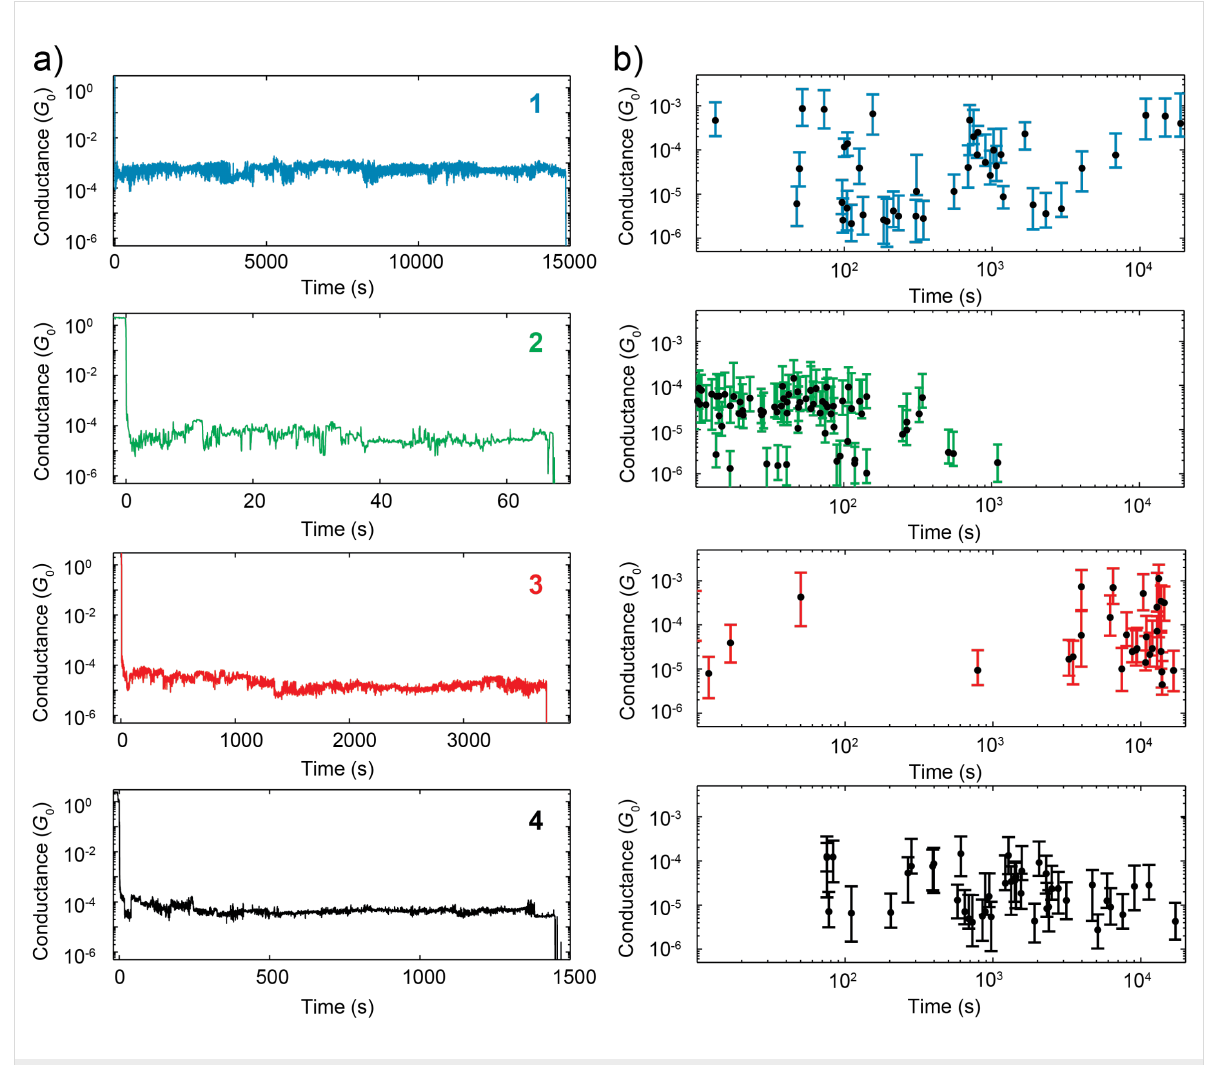
Figure 7: (a) Conductance–time traces measured for self-breaking junctions formed with molecules 1 – 4 . (b) Total time and conductance extracted from the time traces of molecules 1 – 4 ; each dot represents a single conductance–time trace.